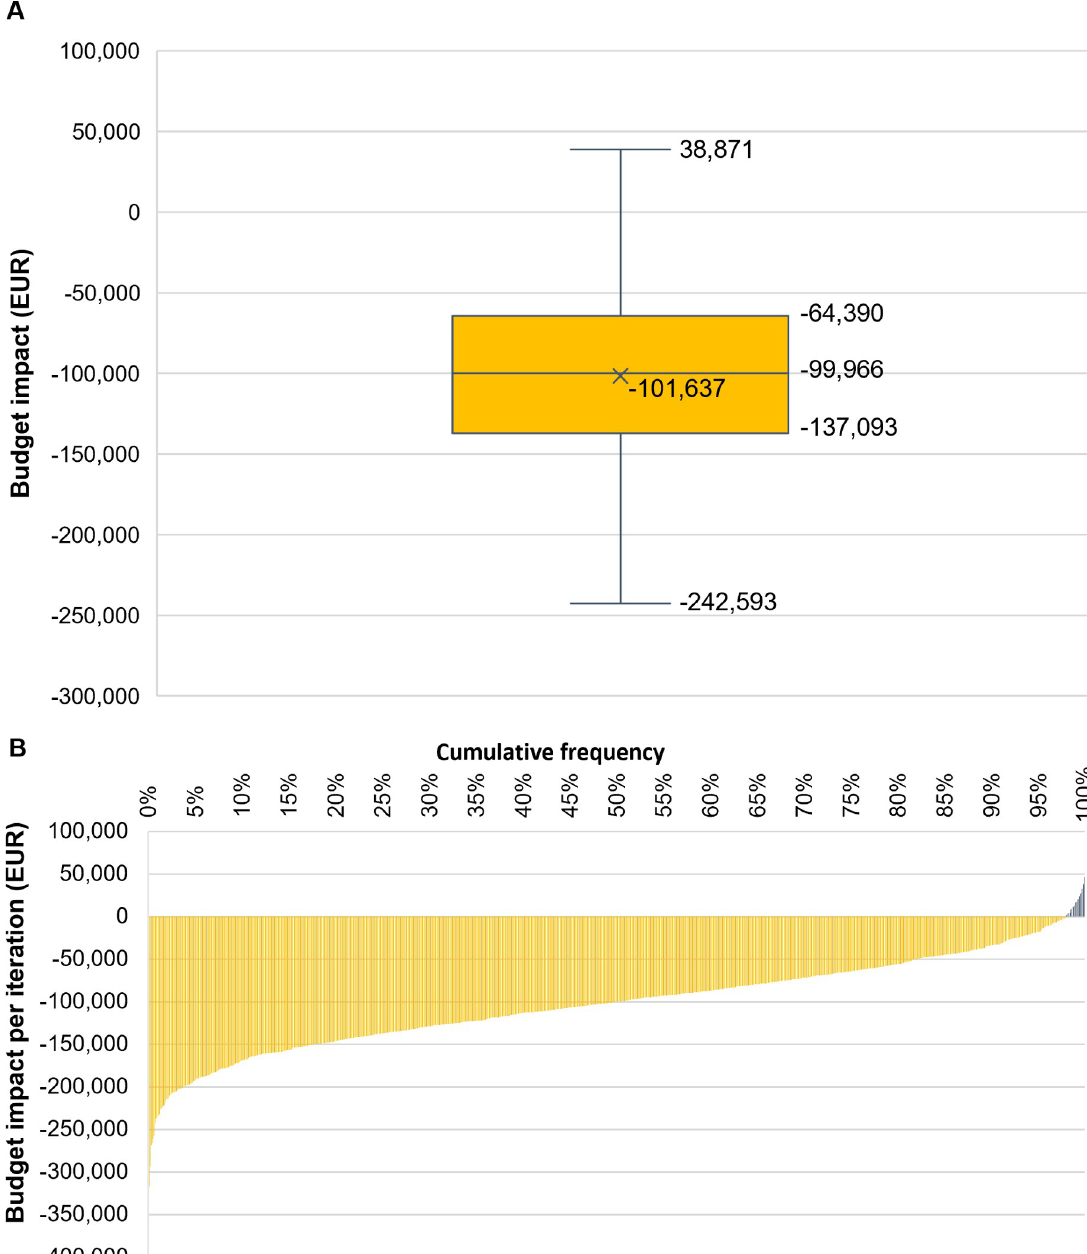
Fig 2. PSA results of the cost impact for the annual caseload. Annual caseload PSA results as A) a box-and-whisker plot and B) cumulative distribution graph. Negative values indicate cost saving with the intervention compared with the comparator. Abbreviations: EUR: Euros; PSA: probabilistic sensitivity